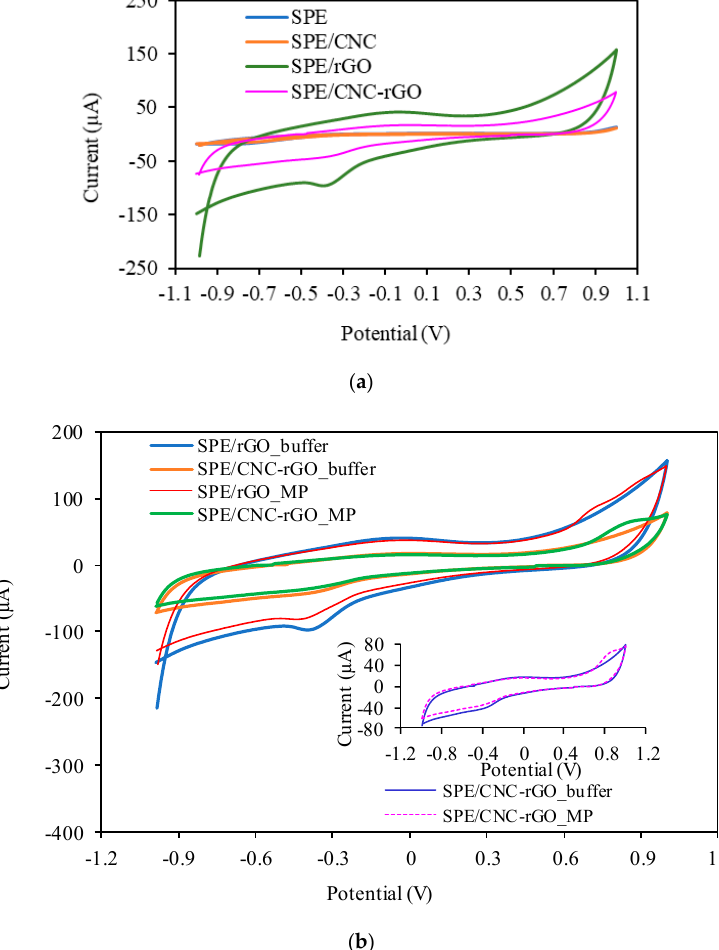
Figure 3. ( a ) Response of the modified electrodes in PBS pH 7.0 (0.05 M); ( b ) response of the modified electrodes in PBS pH 7.0 (0.05 M) and 7 × 10 − 4 M MP.